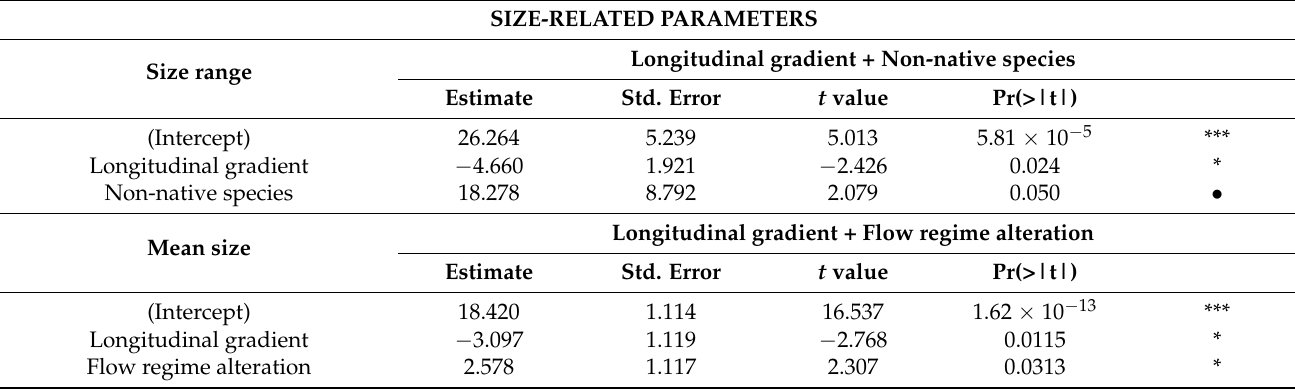
Table 3. General linear models (GLM) results for the best models obtained by model selection analysis based on the Akaike Information Criterion with a correction for small samples sizes (AICc). GLM analysis was conducted for each population trait: CPUE, size- and age-related parameters, growth and somatic condition. ( • p < 0.1; * p < 0.05; ** p < 0.01; *** p <